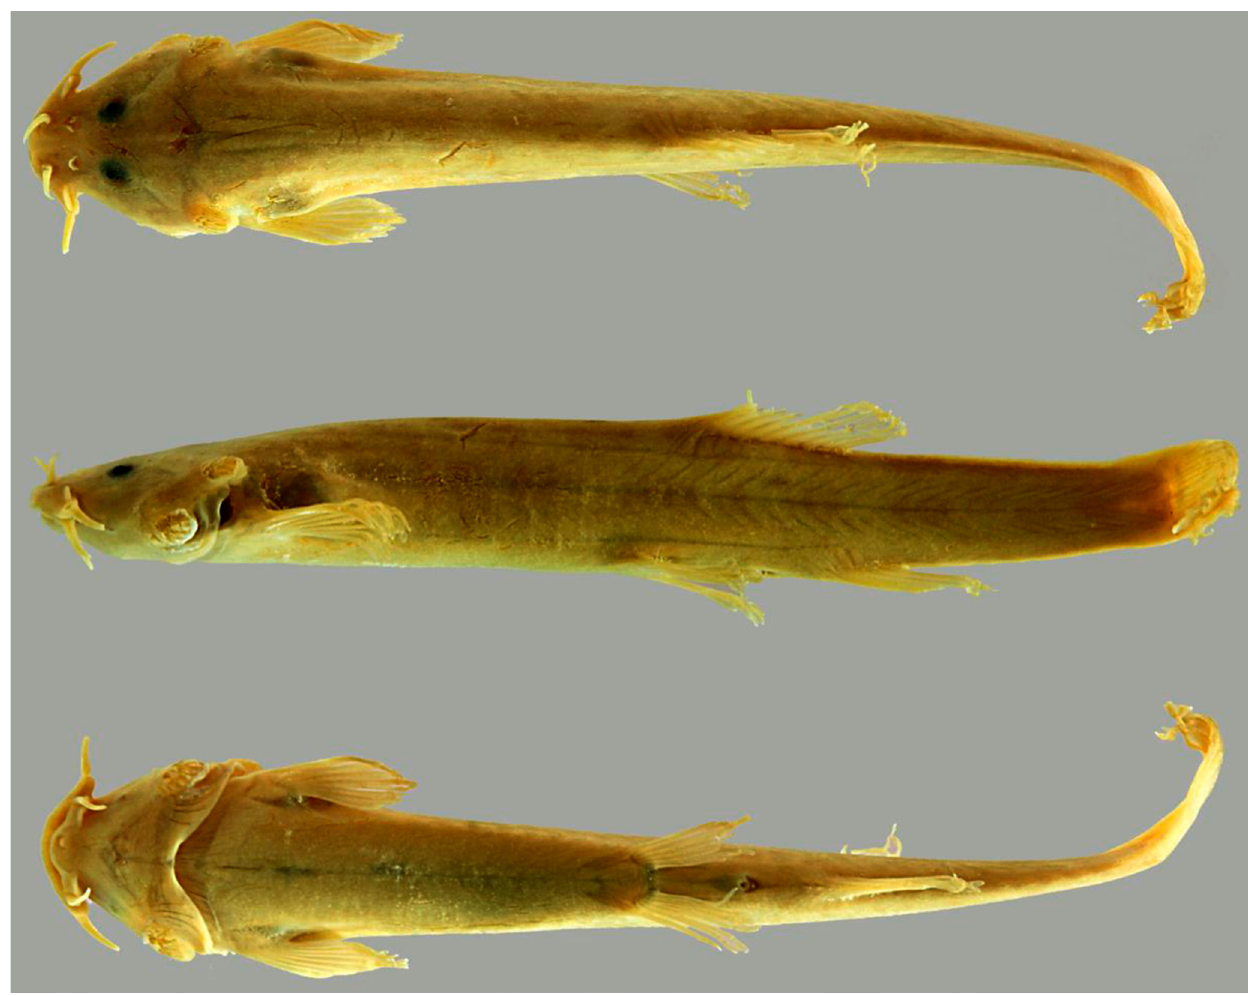
FIGURE 20 | Scleronema minutum , paratype of Pygidium angustirostris (MNRJ 3605; 32.4 mm SL), Uruguay, Paysandú, cañada de las Piedras Blancas, tributary to río Queguay, lower rio